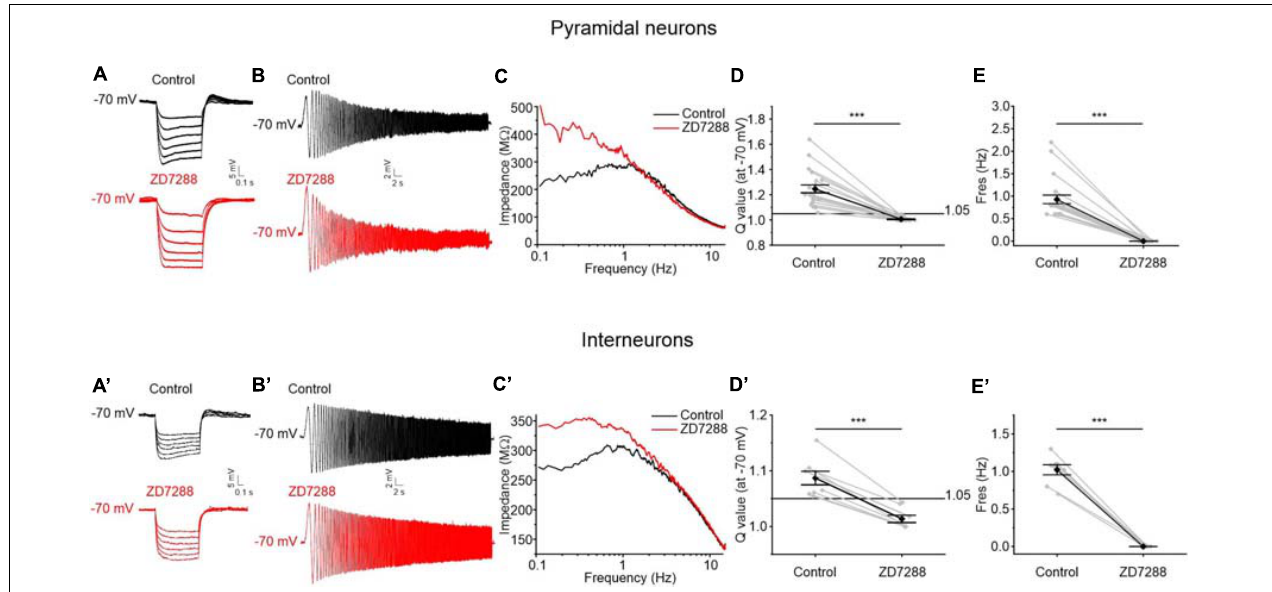
FIGURE 8 | Effects of the block of HCN channels on resonant behavior of pyramidal neurons (A–D) and GABAergic interneurons (A (cid:48) –D (cid:48) ) of the PRC. (A) Representative voltage traces evoked by applying hyperpolarizing current steps to a resonant pyramidal neuron. A prominent “ sag” appears in the voltage responses (upper traces in black) and is abolished after administration of the HCN blocker ZD7288 10 µ M (lower traces in red). (B) Voltage responses of a representative resonant pyramidal neuron to the standard 0–15 Hz ZAP protocol at –70 mV before (upper trace in black) and after (lower trace in red) the perfusion of ZD7288 10 µ M. (C) Impedance-to-frequency relationship of the same cell as in (B) , before (black line) and after (red line) ZD7288 perfusion. (D,E) Scatter plots comparing the Q -values (C) and F res values (D) derived from resonant pyramidal neurons ( N = 21) before (Control) and after (ZD7288) blocking the HCN channels (gray dots and lines). Mean ± SEM. Q -values are reported on the same plot in black. In ZD7288 condition, the resonant behavior is completely abolished. (A (cid:48) –D (cid:48) ) Same as (A–D) for GABAergic interneurons ( N = 8): also in GABAergic interneurons ZD7288 administration completely abolishes “ sag ” (A (cid:48) ) and resonant behavior (B (cid:48) –D (cid:48) ) . Data in (D,E,D (cid:48) ,E (cid:48) ) were compared by paired Student’s t -test. *** p <